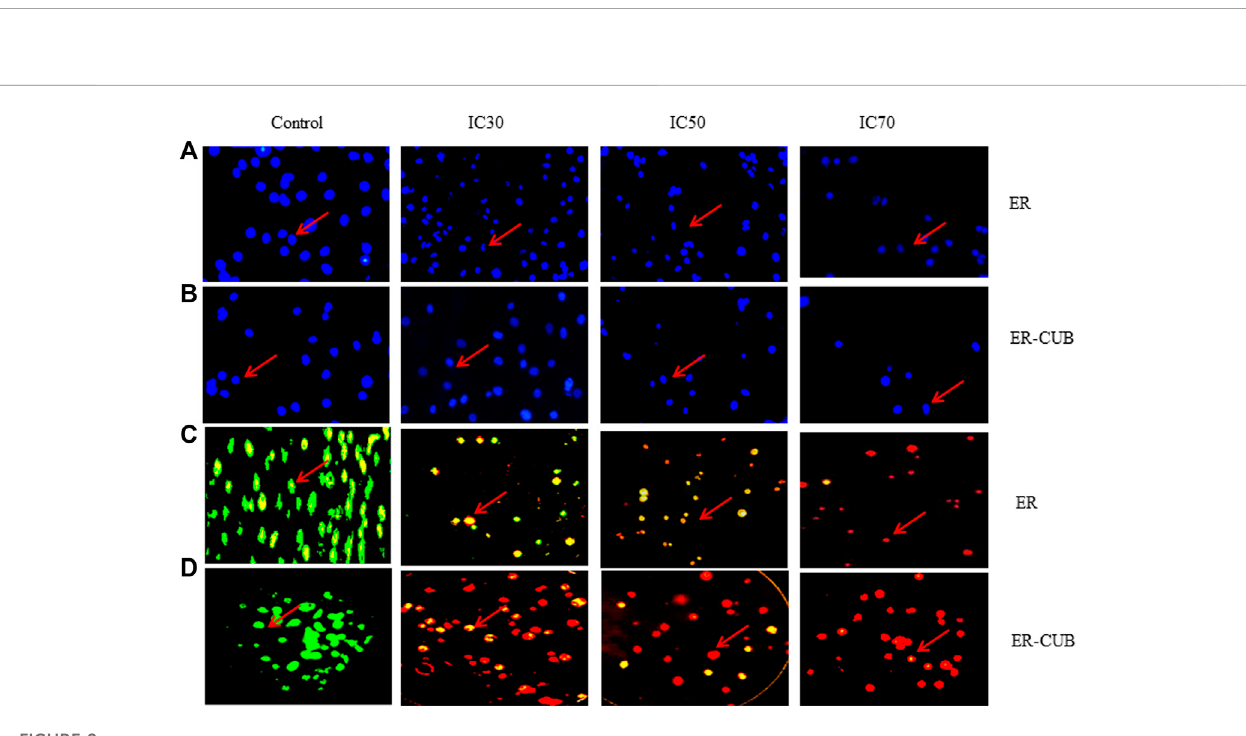
from the standard curve obtained for gallic acid. It was found that ER and ER-CUB exhibited the reduction ability of 24.47±0.52 and 38.52±0.82 μ g/ml, respectively.